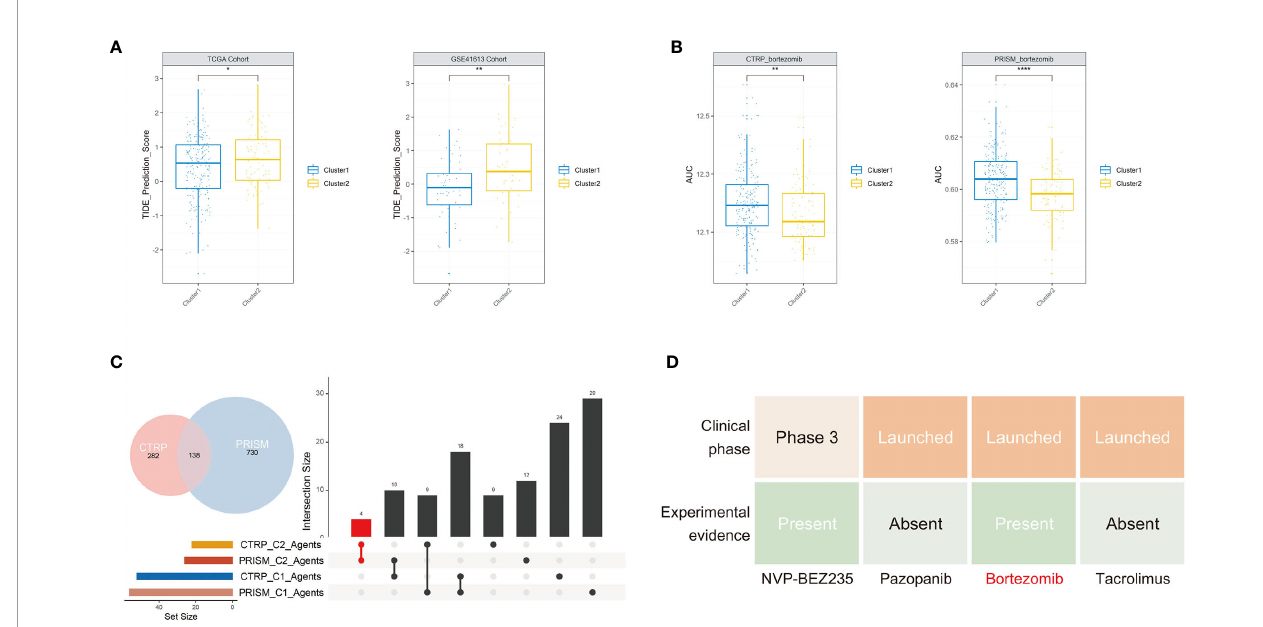
FIGURE 5 | Potential treatment strategy of the two clusters. (A) Cluster 2 group occupied a signi fi cantly higher TIDE score in the two cohorts. (B) The predicted AUC values of bortezomib from the CTRP and PRISM cohorts were decreased in cluster 2 patients. (C) The upsetR plot revealed only the AUC of four agents simultaneously decreased in cluster 2 patients estimated by the CTRP and PRISM cohorts. (D) Identi fi cation of the most promising cluster 2-speci fi c agents according to evidence from multiple sources (* P < 0.05, ** P < 0.01, **** P <